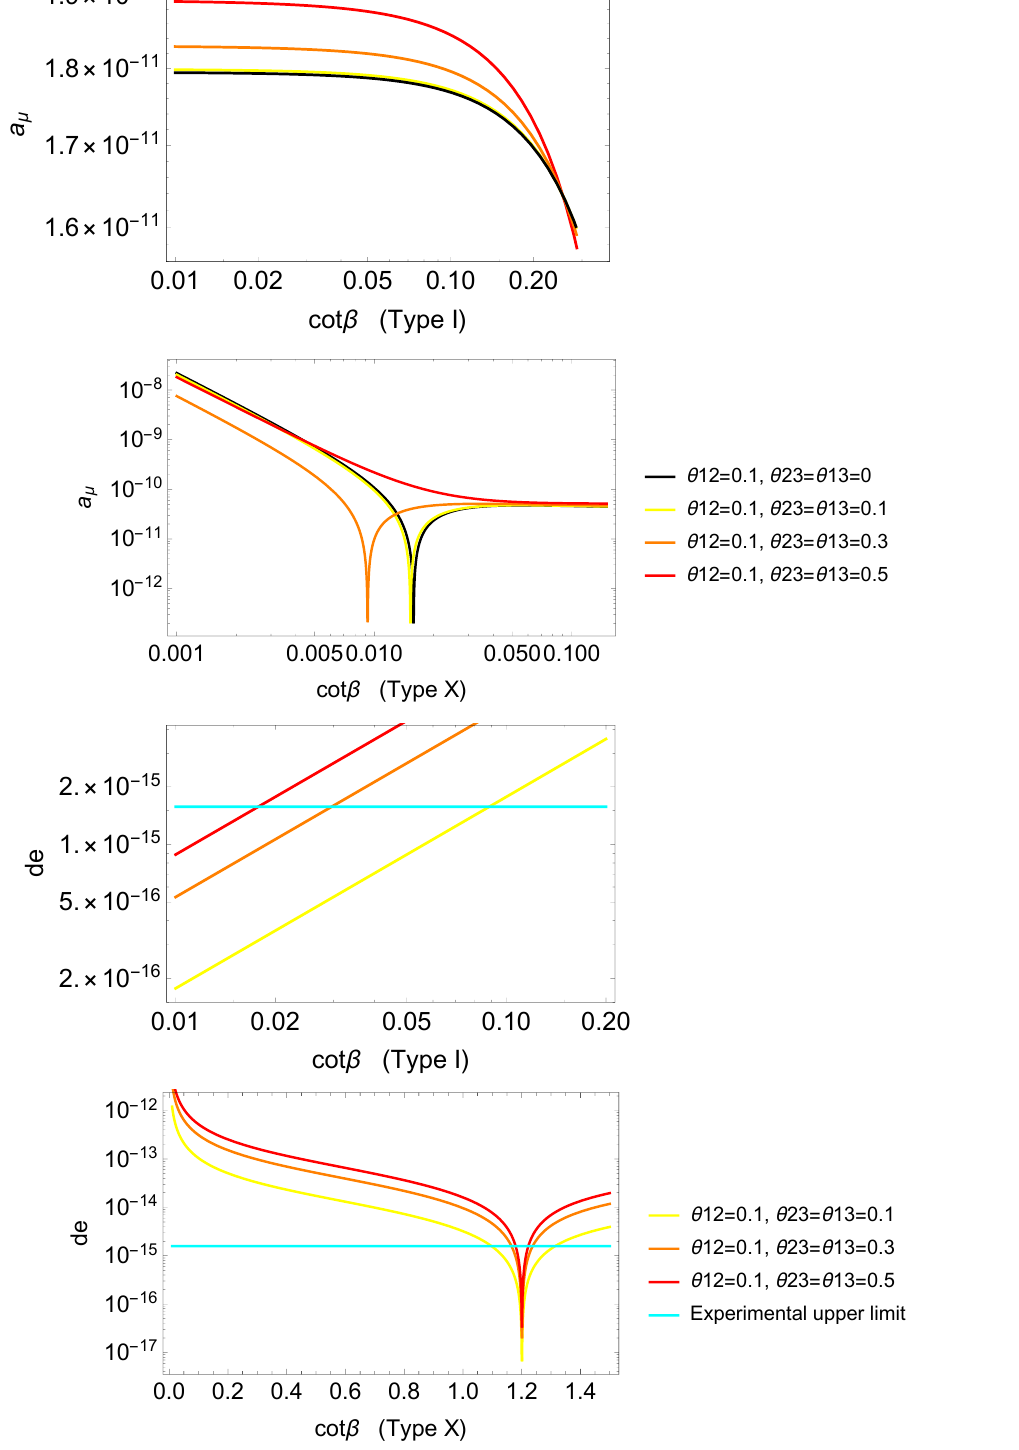
Figure 7 . a (cid:22) (top) and d e (bottom) values in Type I (left) and Type X (right) for di(cid:11)erent values of angles and (cid:12)xed values of masses ( m h = 200 ; 300 GeV). The behaviour of Type Y and II are 2 ; 3 similar to Type I and X, respectively.